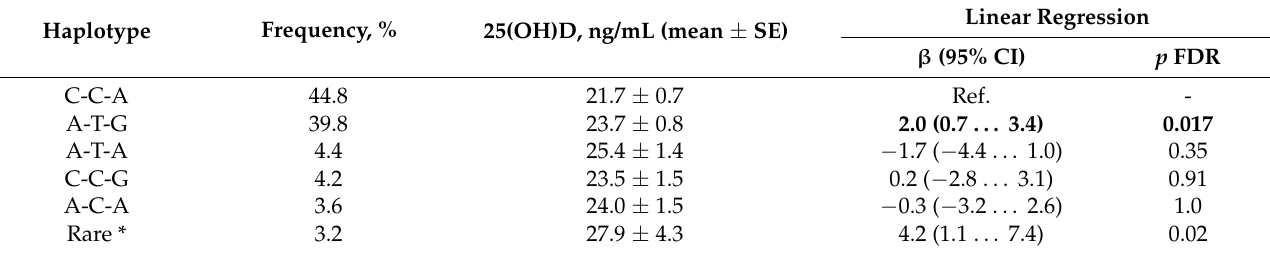
Table 4. The association of VDR rs7975232, rs1544410, and rs731236 haplotypes with serum 25(OH)D levels. Haplotype Frequency, % 25(OH)D, ng/mL (mean ± SE)